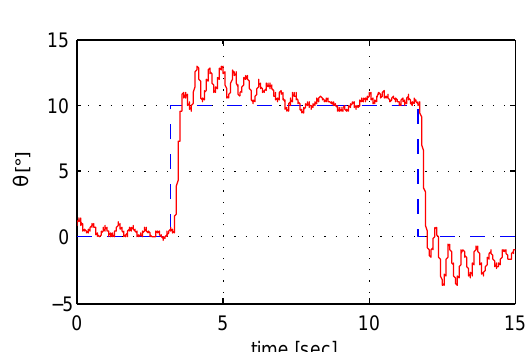
Figure 3. Pitch angle step response.